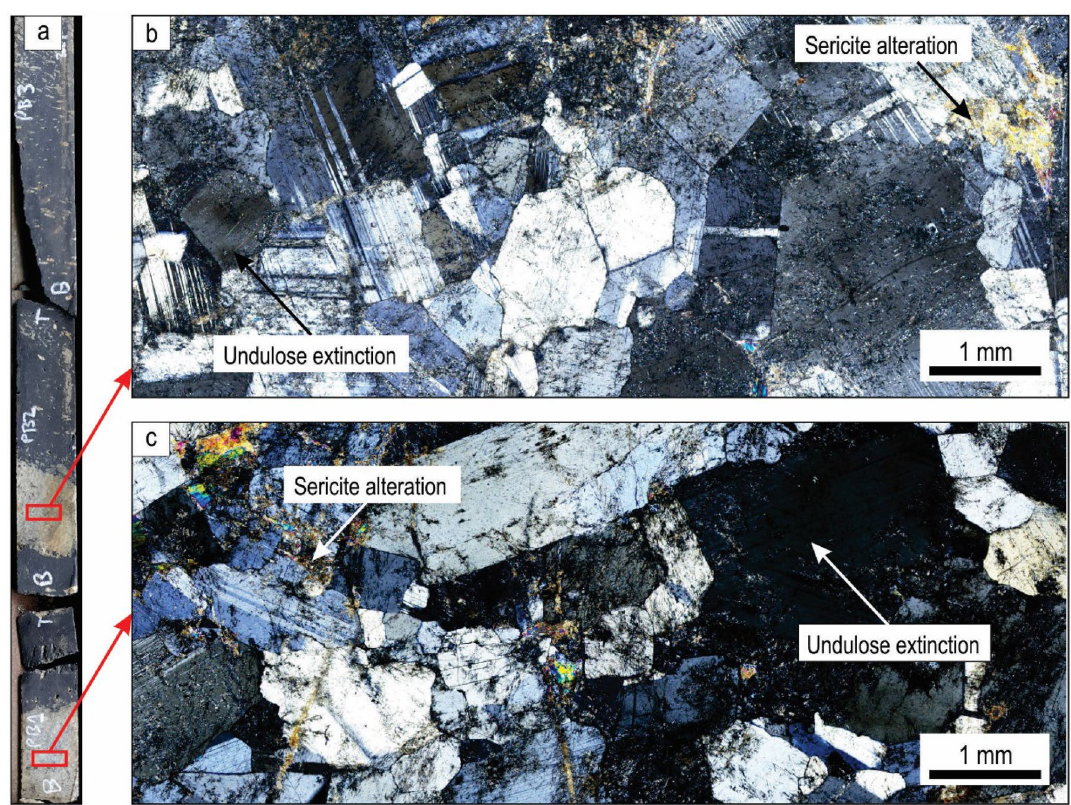
Figure 2. Petrography of footwall anorthosite and anorthosite inclusions in massive magnetitite. (a) Drill core from which samples were collected. The drill core measures about 4.5 cm across. Thin sections of both an inclusion (b) and the footwall anorthosite (c) are shown in crossed polarized light. The two samples are petrographically indistinguishable from each other and are both characterized by the near-absence of any primocrysts other than plagioclase, a similar degree of deformation in the form of undulose extinction, a seriate fabric and some degree of sericite